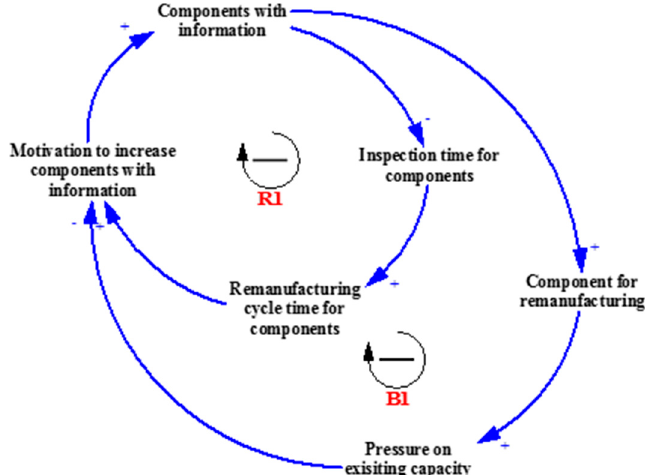
Figure 4. CLD indicating the dynamic implications of component data on the remanufacturing system for the component.